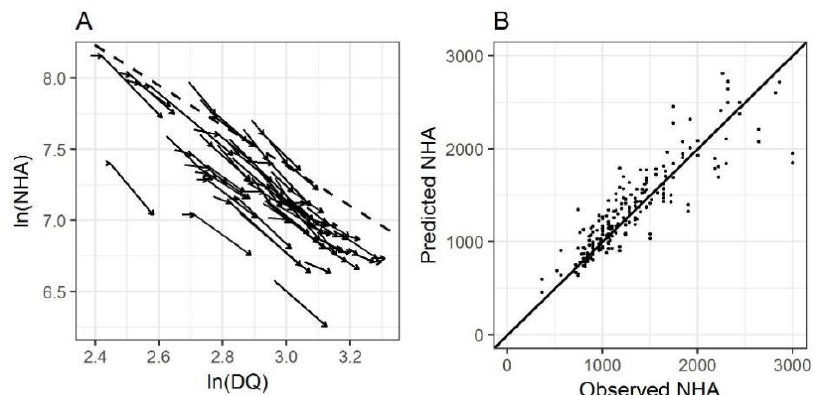
Figure 5. ( A ) Quadratic diameter (DQ) vs. number of trees per hectare (NHA) trajectories of measured stands of the PP series. The dashed line is the DQ max for N. alpina . ( B ) Observed vs. projected values of number of trees.